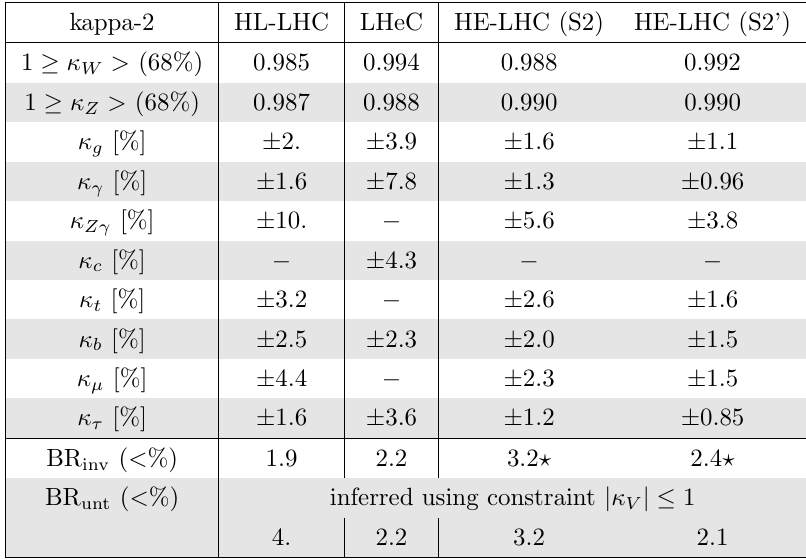
Table 28 . Expected relative precision (%) of the (cid:20) parameters in the kappa-2 (standalone) scenario described in section 2 for the HL-LHC,LHeC, and HE-LHC. A bound on j (cid:20) V j (cid:20) 1 is applied since no direct access to the Higgs width is possible, thus the uncertainty on (cid:20) W and (cid:20) Z is one-sided. For the remaining kappa parameters one standard deviation is provided in (cid:6) . The corresponding 95%CL upper limit on BR inv is also given. In this scenario BR unt is a (cid:13)oating parameter in the (cid:12)t, to propagate the e(cid:11)ect of an assumed uncertain total width on the measurement of the other (cid:20) i . Based on this constraint the reported values on BR unt are inferred. The 95% CL upper limits are given for these. Cases in which a particular parameter has been (cid:12)xed to the SM value due to lack of sensitivity are shown with a dash ( (cid:0) ). In the case of (cid:20) t sensitivity at the LHeC, note that the framework relies as input on (cid:22) ttH , and does not take into consideration (cid:22) tH . A star ( ? ) indicates the cases in which a parameter has been left free in the (cid:12)t due to lack of input in the reference documentation. The integrated luminosity and running conditions considered for each collider in this comparison are described in table